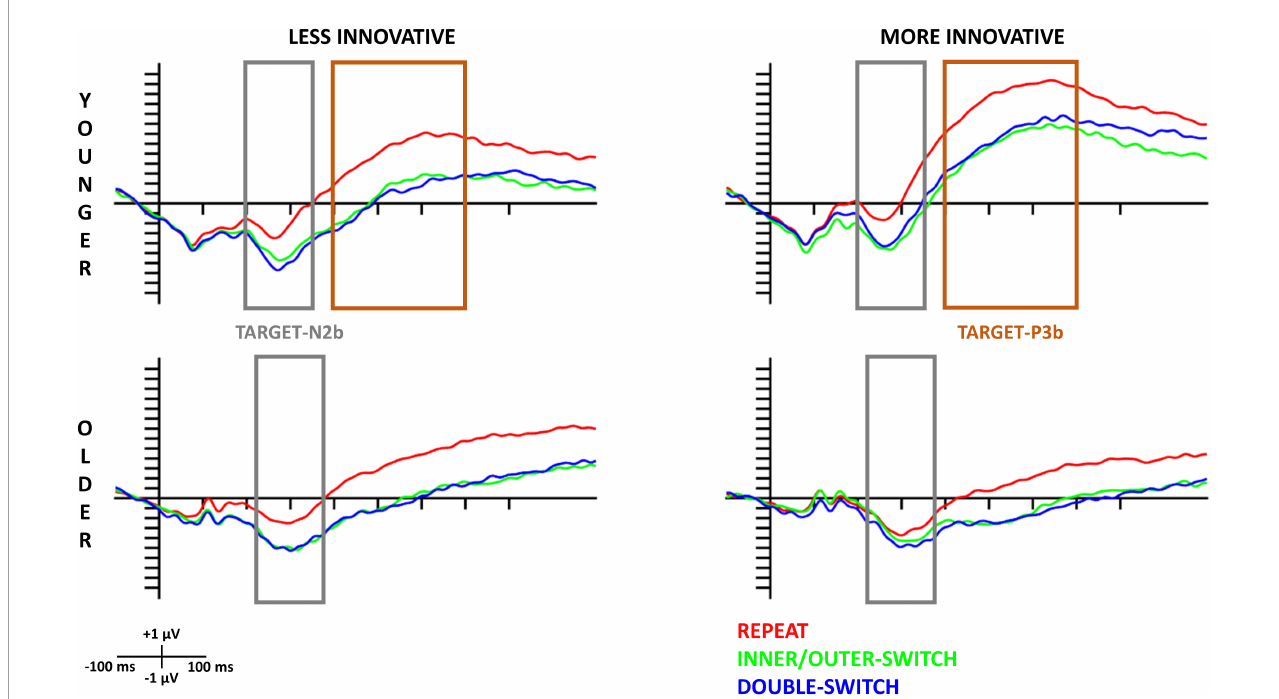
FIGURE4 Target-locked N2b and P3b components at the Cz electrode site for each Switch-type in the innovative creativity groups. The gray rectangles show the time window (younger: 200–350 ms, older: 230–380 ms) where the amplitude averages were calculated for N2b; and the orange rectangles show the time window (400–700 ms) where the amplitude averages were calculated for P3b in the younger age-group. The 0 ms time point on the x -axis is locked to the target (pair of double geometrical forms) presentation.